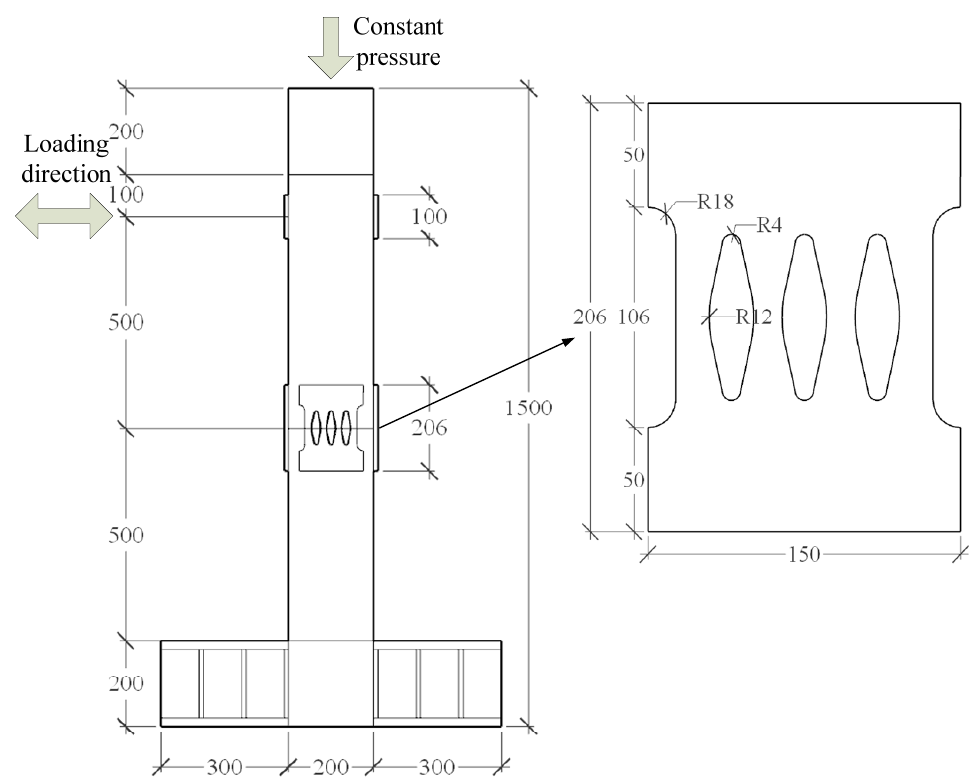
Figure 3. Dimensions of the specimen of the precast assembled bridge pier (unit: mm).